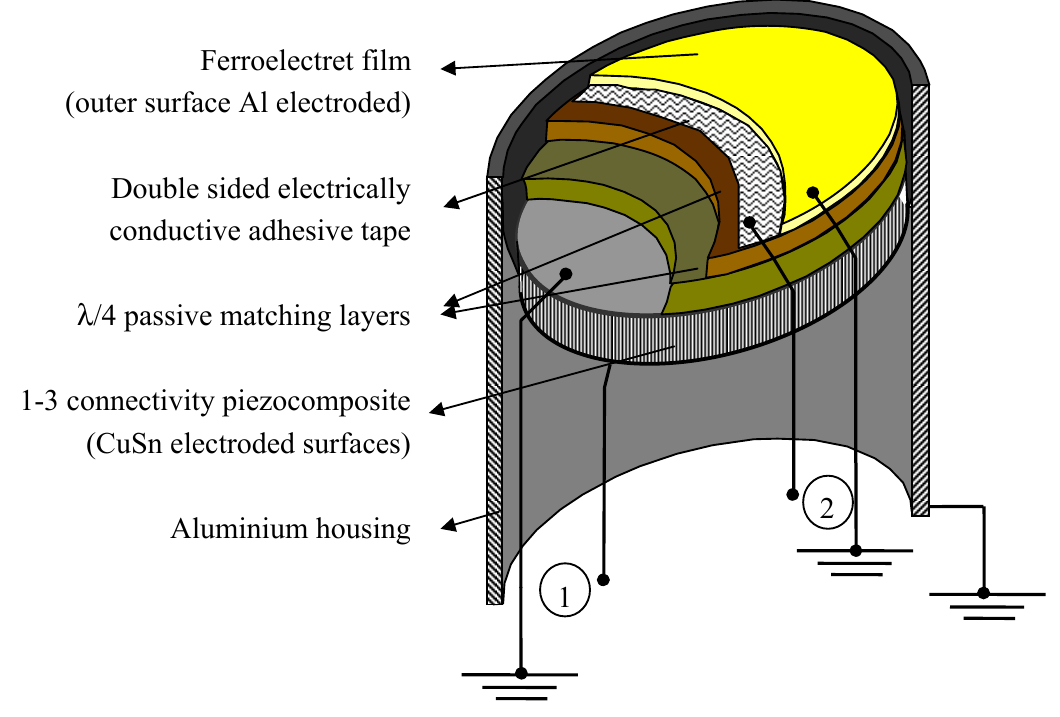
Figure 1. Schematic view of the cross-section of the air-coupled transducer with one active matching layer. 1: piezocomposite disk electrical terminals, 2: ferroelectret film electrical terminals. Ground connections are also